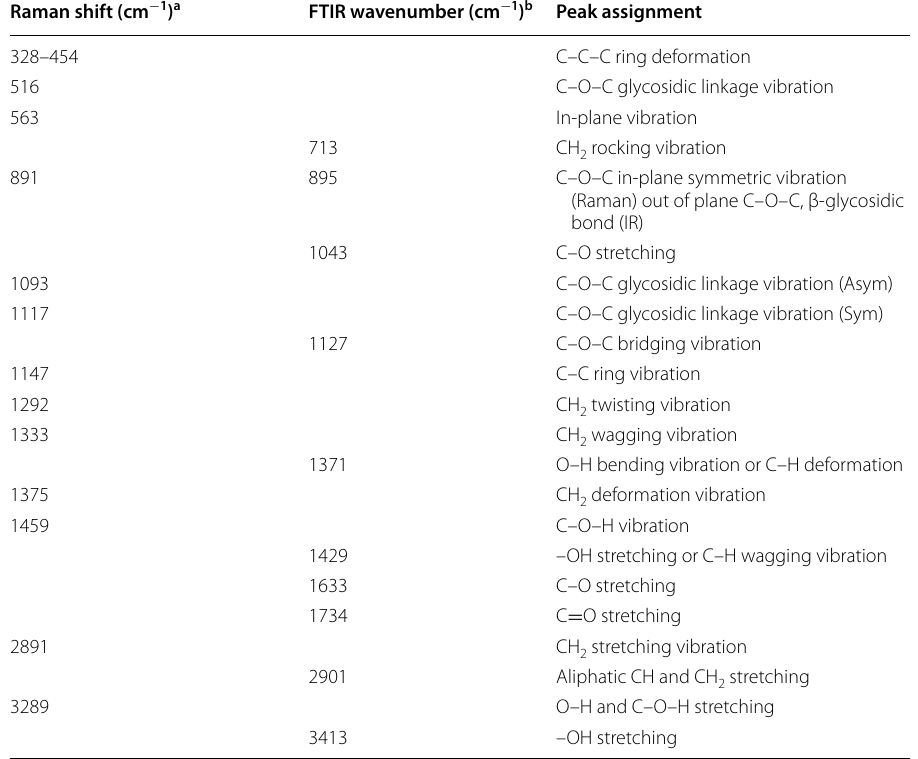
Table 1 Raman and FTIR peak